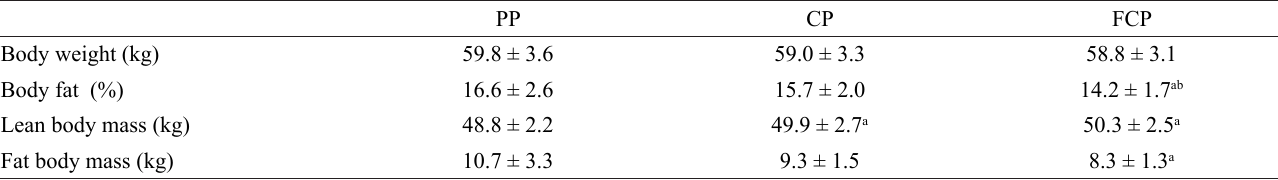
Table 2. Effect of selective loads periodization on body composition of female futsal players in the beginning of the preparatory (PP), competitive (CP) and final competitive period (FCP).